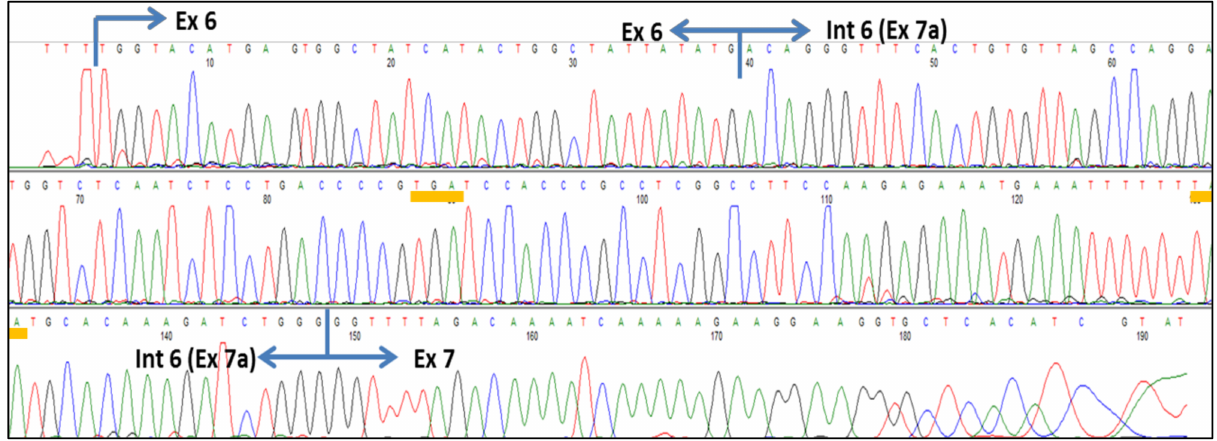
Figure 3. Partial nucleotide sequence of SMN2 exon 6 to exon 7 showing the activated cryptic exon in intron 6. Blue arrows indicate the exon border. Yellow underlines indicate premature stop codons. Intron 7 retention: ASO-NUS at concentrations of 50, 100, and 200 nM produced no intron-7-containing transcripts (no bands of Ex6/Ex7/In7/Ex8 in Figure